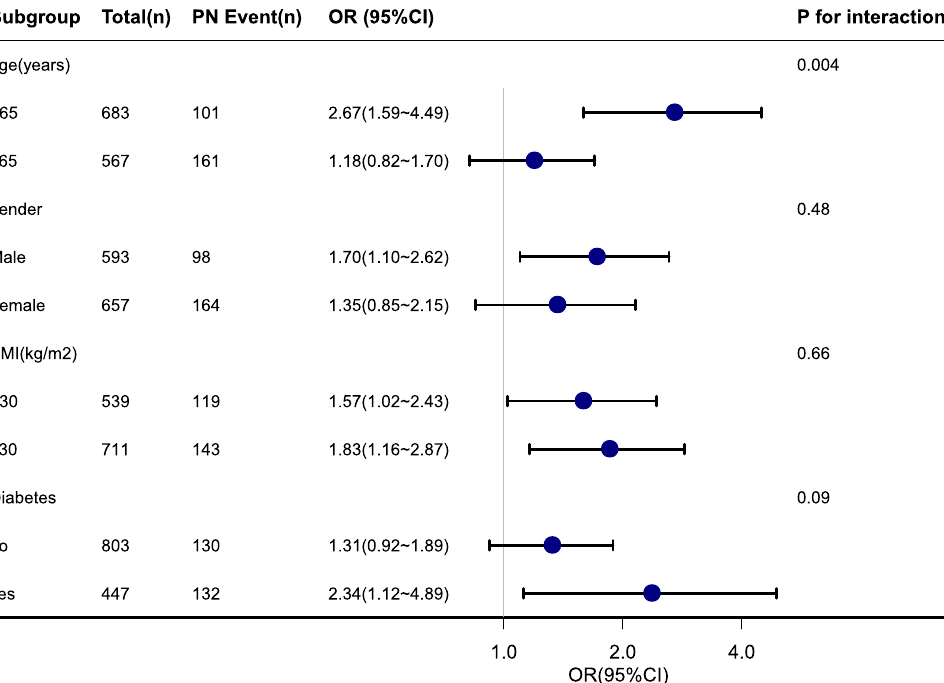
Figure 2. Subgroup analyses of association between NAFLD and PN. NAFLD non-alcoholic fatty liver disease, PN peripheral neuropathy, BMI body mass index, PIR poverty income ratio, PA physical activity, OR odds ratio, CI confidence interval, Ref reference. Each stratification was adjusted for ethnicity, education, PIR, smoking status, alcohol consumption, PA, Hypertension and